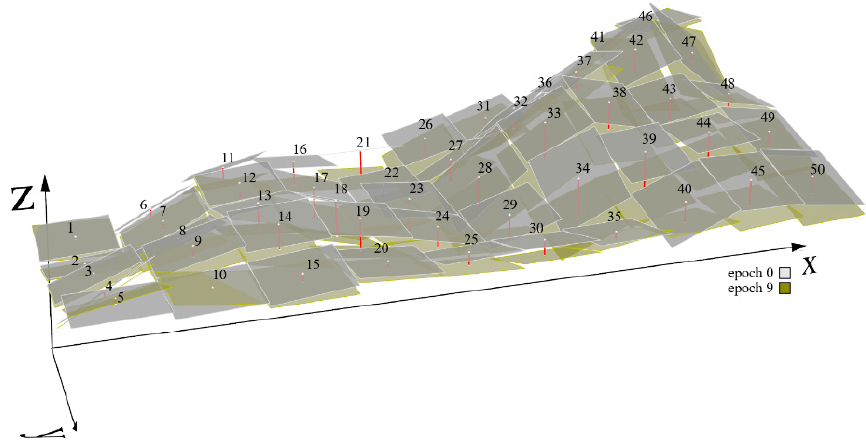
Figure 9. Fitted planes layout for all sectors in every epoch.